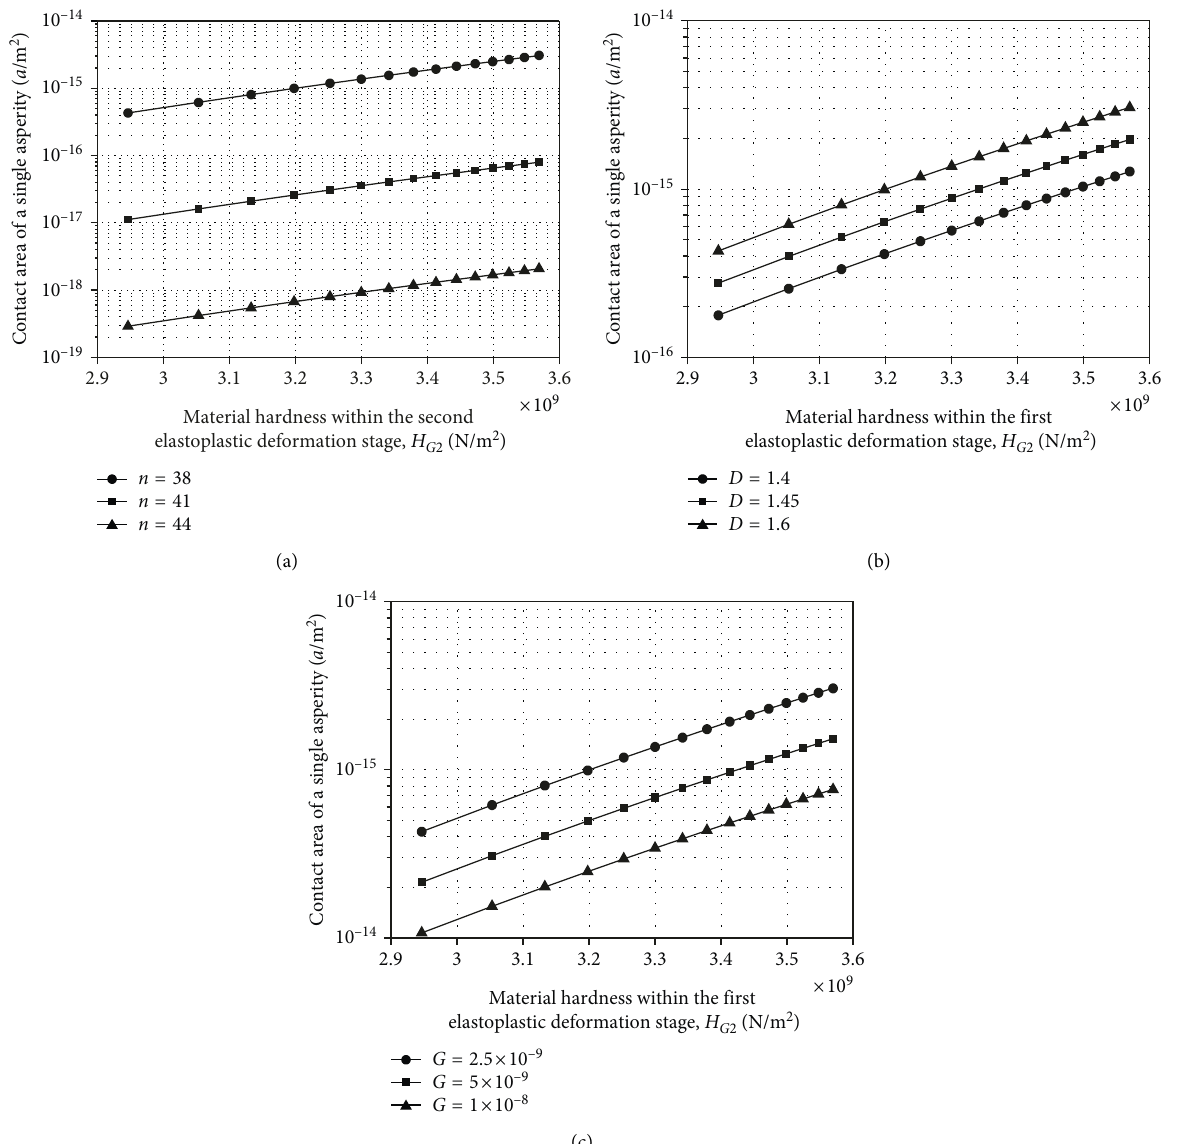
Figure 11: Relationships between the material hardness and contact area of a single asperity within the second elastoplastic deformation stage. (a) D � 1 . 5 , G � 2 . 5 × A r / A a � 0 . 4. (b) n � 38 ,G � 2 . 5 × 10 − 9 , A r / A a � 0 . 4. (c) n � 38 ,D � 1 . 5 , A r / A a � 0 .